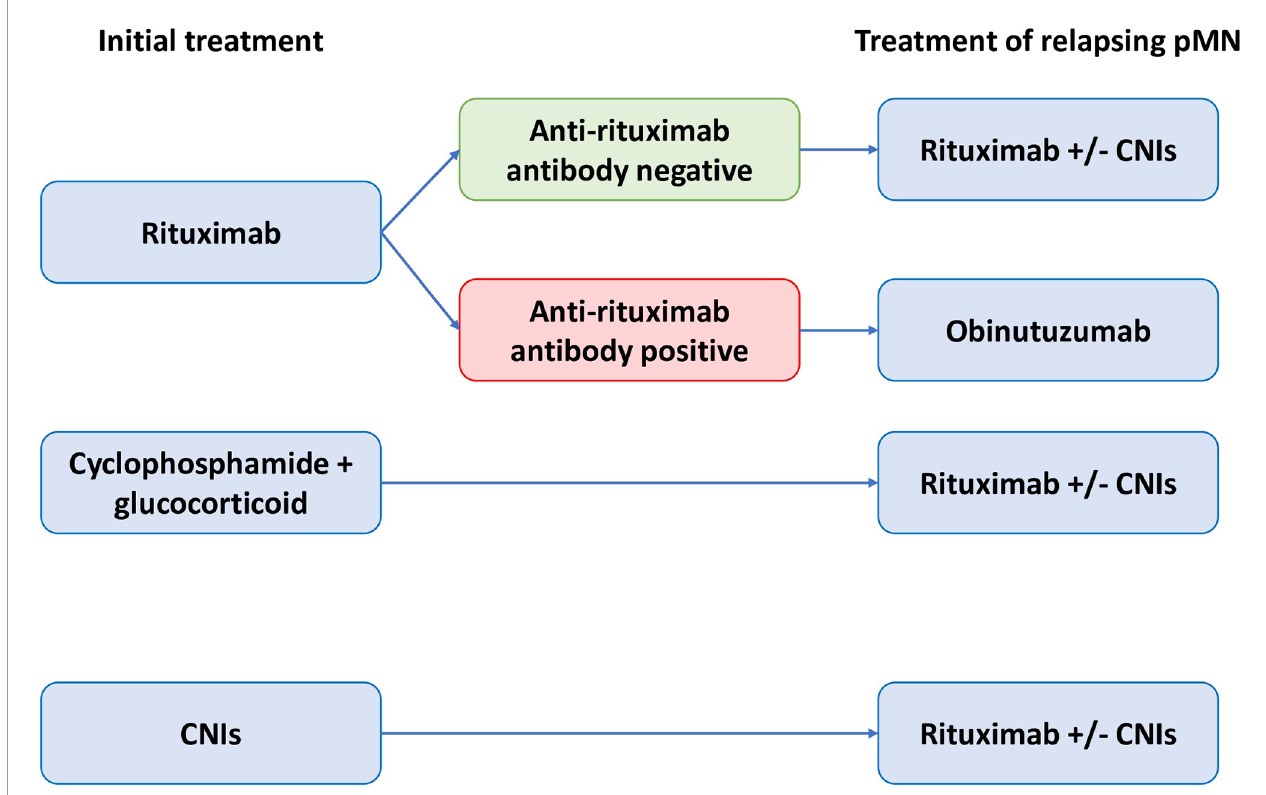
FIGURE 5 | Algorithm for management of patients with relapsing primary membranous nephropathy. CNIs, calcineurin inhibitors; pMN, primary membranous